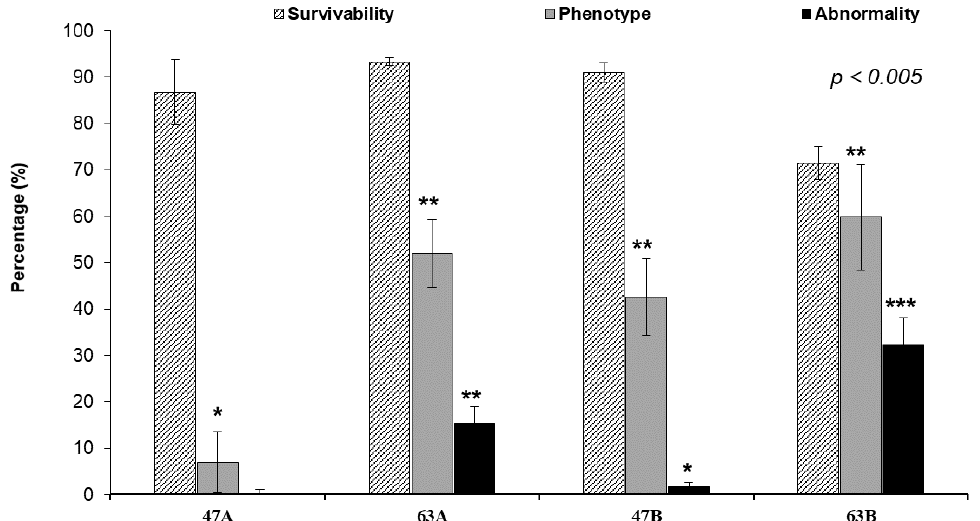
Figure 3. Bar graph comparing the efficiency of slc24a5 TALENs (activity, phenotype, and toxicity) in two different target loci (A and B) of two selected TALE scaffolds (+153/+47 and +136/+63). Data are mean ± SEM (standard error of the mean) for all three parameters (Survivability, Phenotype, and Abnormality) for each TALEN target, with three replicates. Asterisks indicate significant differences ( p < 0.005) between each TALEN target. Table 2. Survival rate of kawakawa embryos injected with TALENs. Numbers and percentages of embryos surviving during normal and abnormal development at 12 h post fertilization.